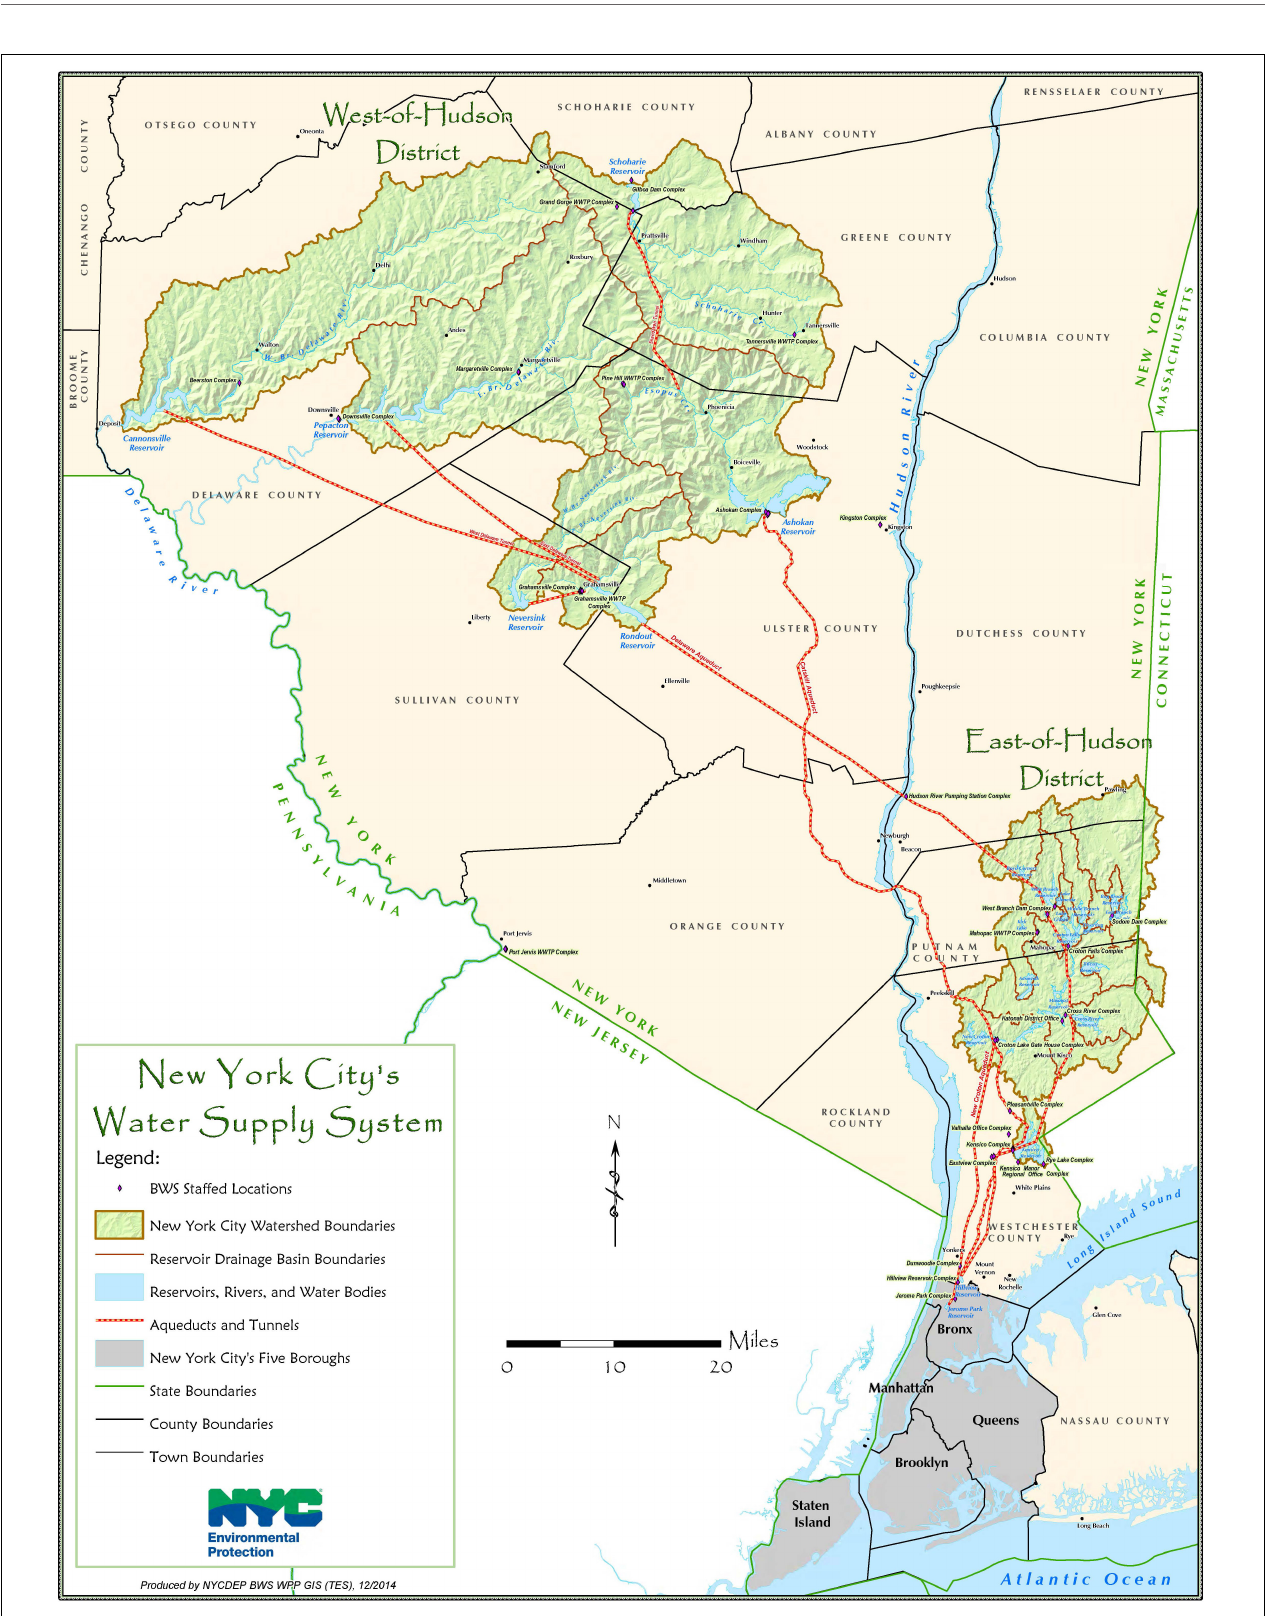
FIGURE 5 | New York City’s water supply system, showing the connections to the Upper Delaware watershed. Source: New York City Department of Environmental Protection, Bureau of Water Supply [NYCDEP/BWS] (2014). Permission has been received for all previously published copyrighted figures.